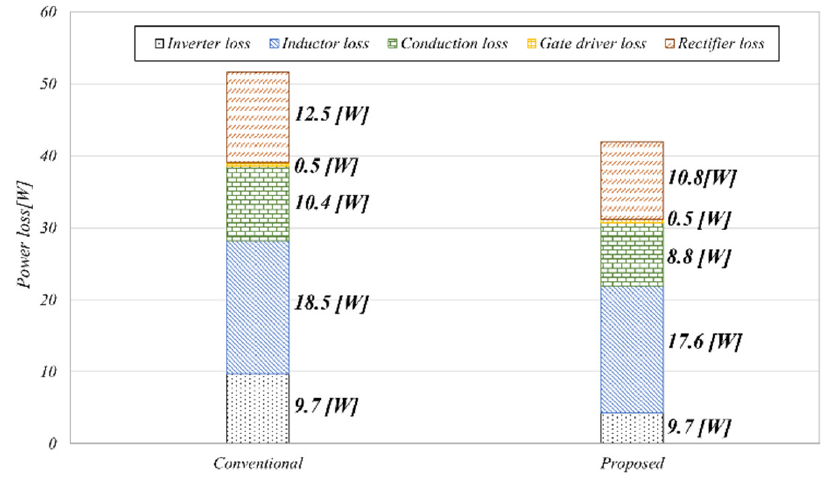
Figure 13. 400 W loss graph of the SS topology with conventional design and proposed design.